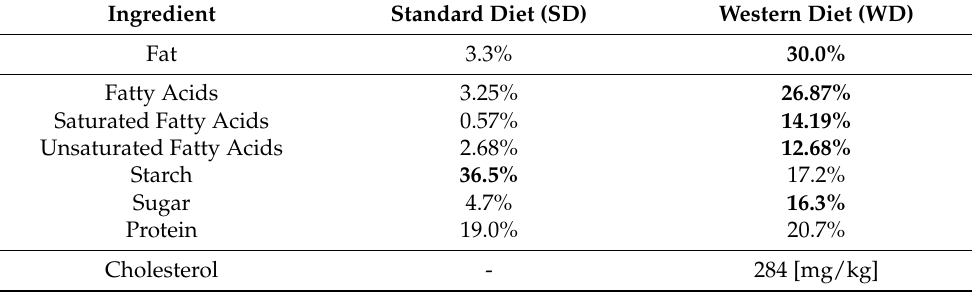
Table 3. The composition of the experimental Western diet (WD) and standard diet